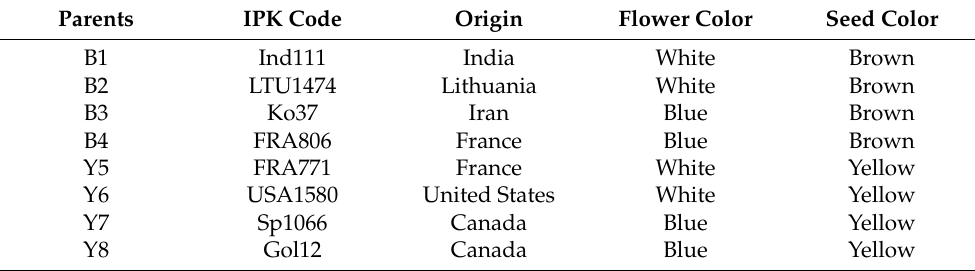
B: brown seed, Y: yellow